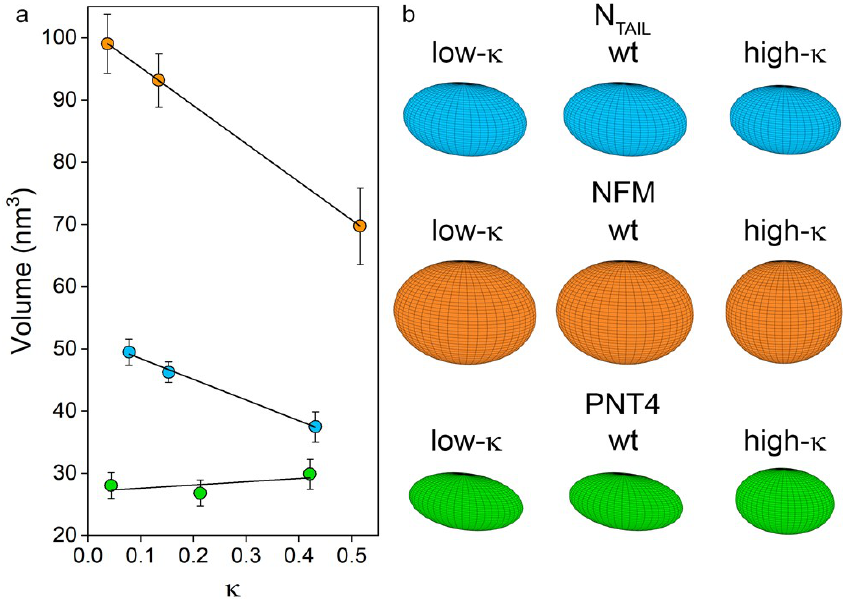
Figure 5. Relationship between ellipsoid volume and κ values. ( a ) Regression of ellipsoid volume and κ for N TAIL (light blue), NFM (orange) and PNT4 (green). The equation of trend lines are: y = − 33.4 x + 51.7, R 2 = 0.987 for N TAIL , y = − 61.2 x + 101.4, R 2 = 0.998 for NFM and y = 4.3 x + 27.2, R 2 = 0.710 for PNT4. Mean values of three independent measurements are represented, with error bars indicating standard deviations. ( b ) Geometry of the model proteins as obtained by applying the ellipsoid model.